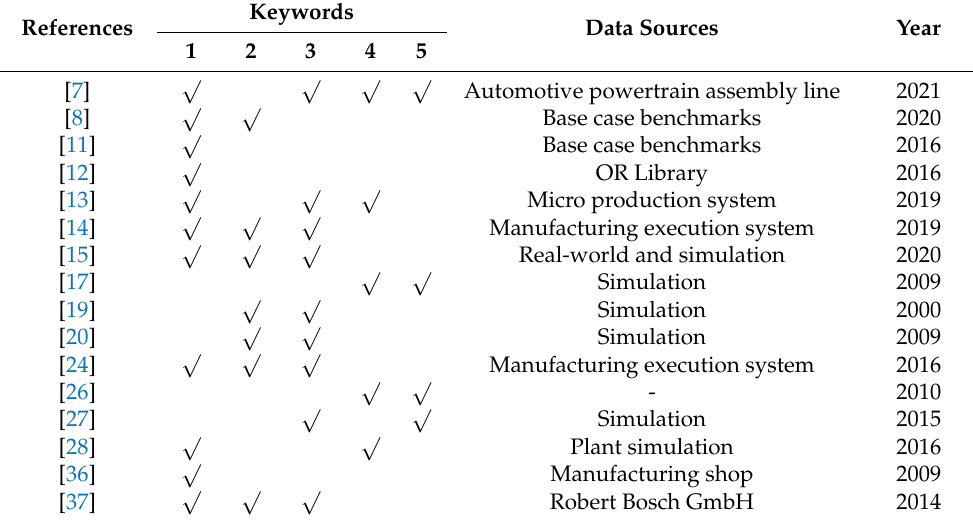
Table 1. Summary of bottleneck